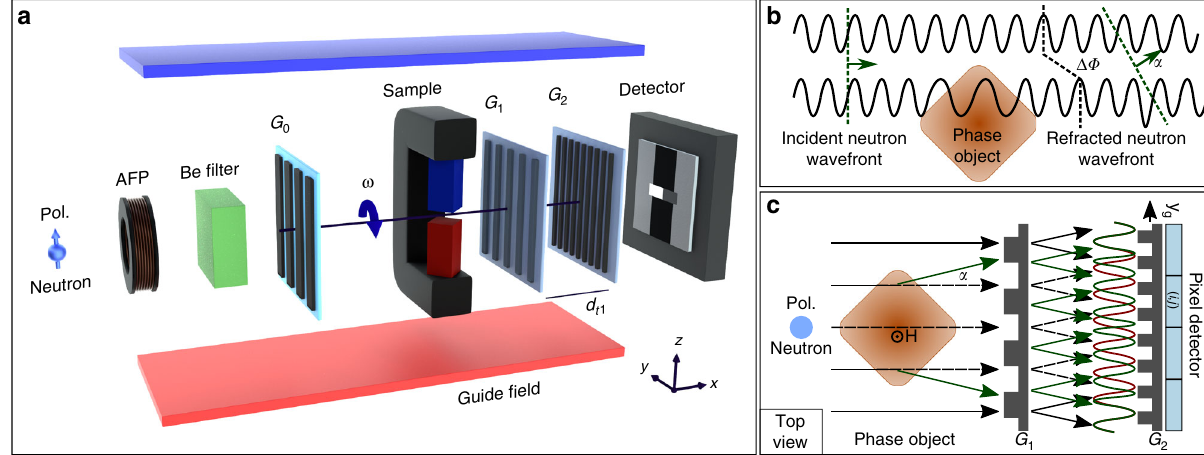
Fig. 1 Experimental setup and principle of polarized neutron grating interferometry (pnGI). a Sketch of the pnGI setup for polarized neutrons. The setup consists of an adiabatic fast passage spin fl ipper (AFP), a beryllium fi lter (Be fi lter), a source grating G 0 , a phase grating G 1 , an analyzer grating G 2 , a detector, and a guide fi eld system. The magnetic sample is placed between G 0 and G 1 , the North and the South poles are depicted in red and blue, respectively. The parameter ω is the rotation angle of the gratings and the sample around the x -axis, the con fi guration in the sketch corresponds to ω = 0°, and d t 1 is the Talbot distance. b Phase shift, Δ Φ , of the neutron wavefront induced by the magnetic interaction with a phase object, refracted by an angle α . c Schematic top view of a pnGI setup depicting the perturbations of the incident neutron wavefront, induced by refraction on a phase object in the beam, which lead to local displacement of the interference pattern. The intensity modulation is detected by each ( i , j )-pixel on the matrix detector. The phase- stepping approach is adopted by scanning one grating along the transverse direction, y g . Further information about phase-stepping method for pnGI and contrast mechanism can be found in the Supplementary Note 1